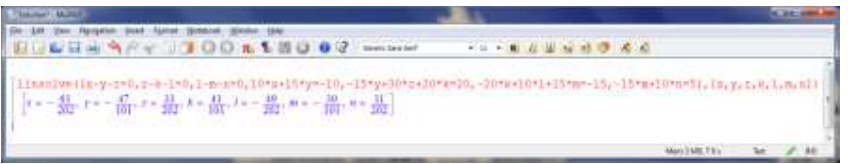
Fig. 5. Numeric solution of the system of equations in